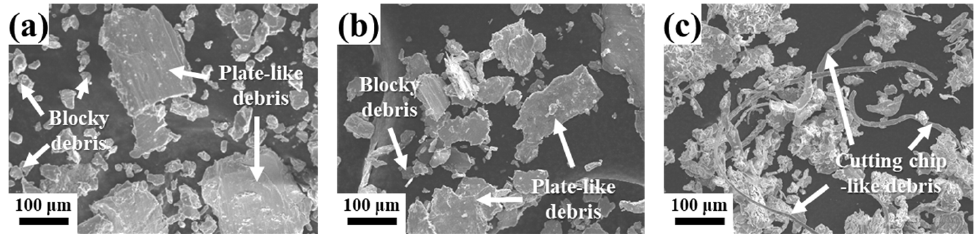
Figure 5. Morphologies of debris collected at the end of wear tests at a rotation speed of 200 rpm and corresponding energy-dispersive X-ray spectroscopy (EDS) analysis; SEM micrographs of wear debris obtained under ( a ) dry, ( b ) water-, and ( c ) oil-lubricated conditions.